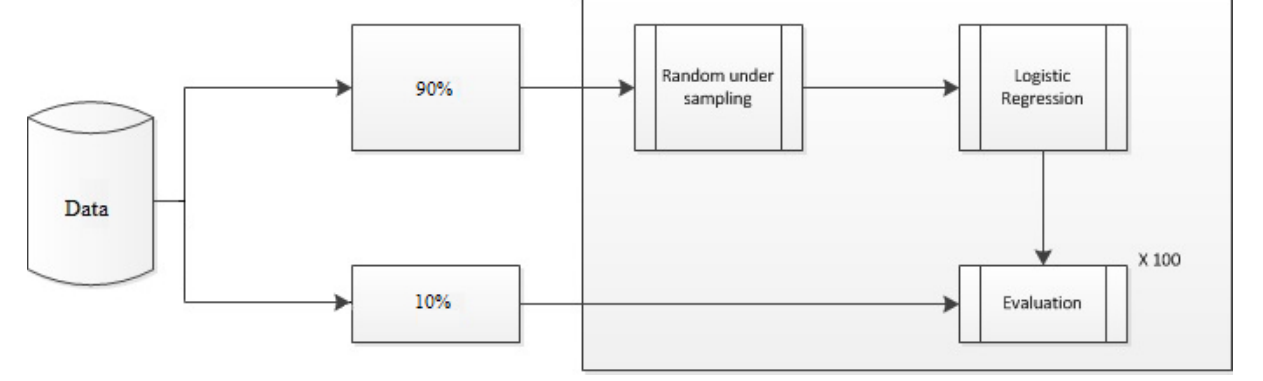
Figure 2. Model generation and evaluation process.